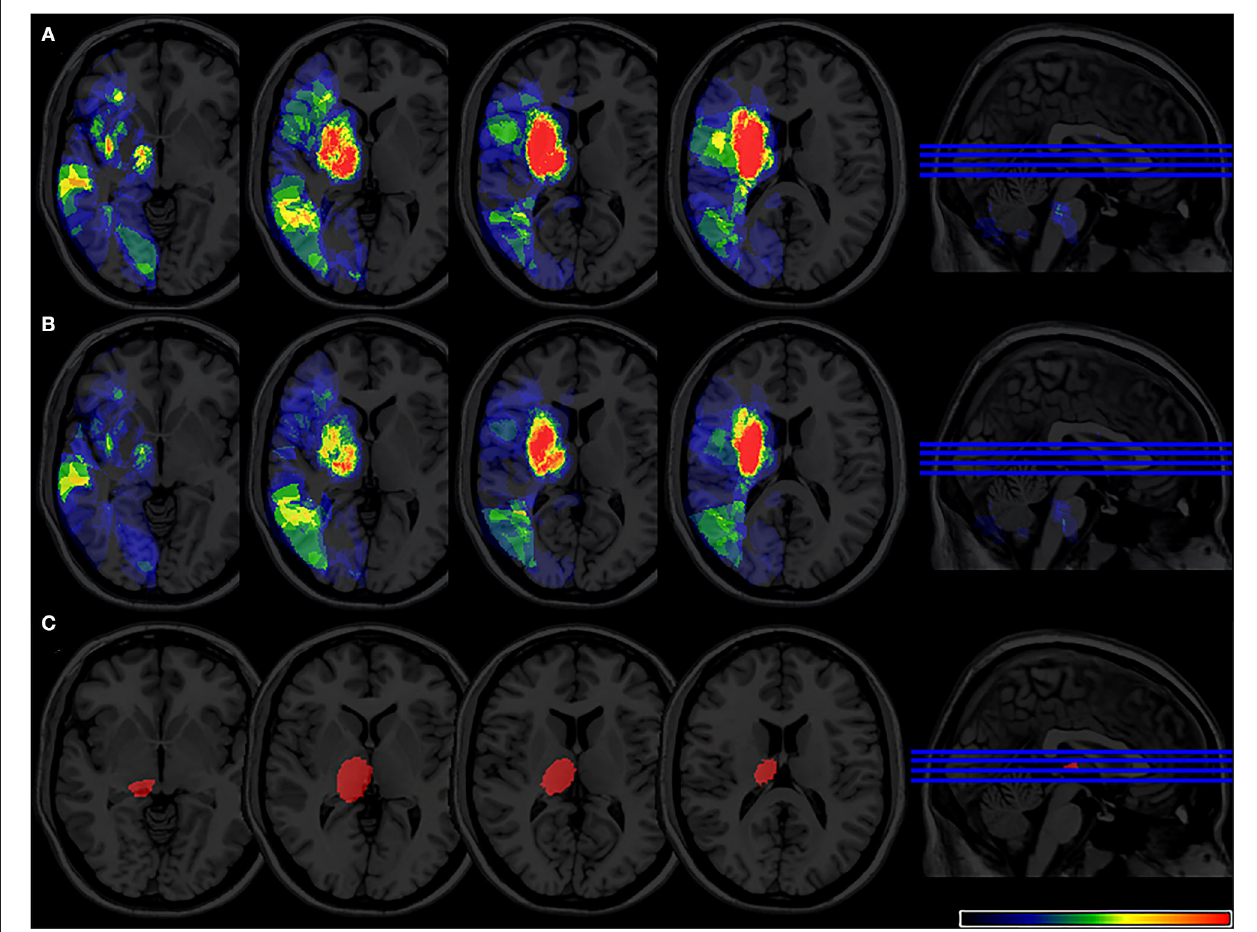
FIGURE 5 | (A) Lesion probability map of 344 patients (17 were excluded due to bilateral lesions) after lesion left-right flipped in the acute phase. (B) Lesion probability map of 309 patients (15 were excluded due to bilateral lesions) after lesion left-right flipped at 6-month follow-up. (C) 2 VLSM results for poststroke fatigue at 6-month follow-up after flipped analysis. VLSM, voxel-based lesion-symptom mapping.